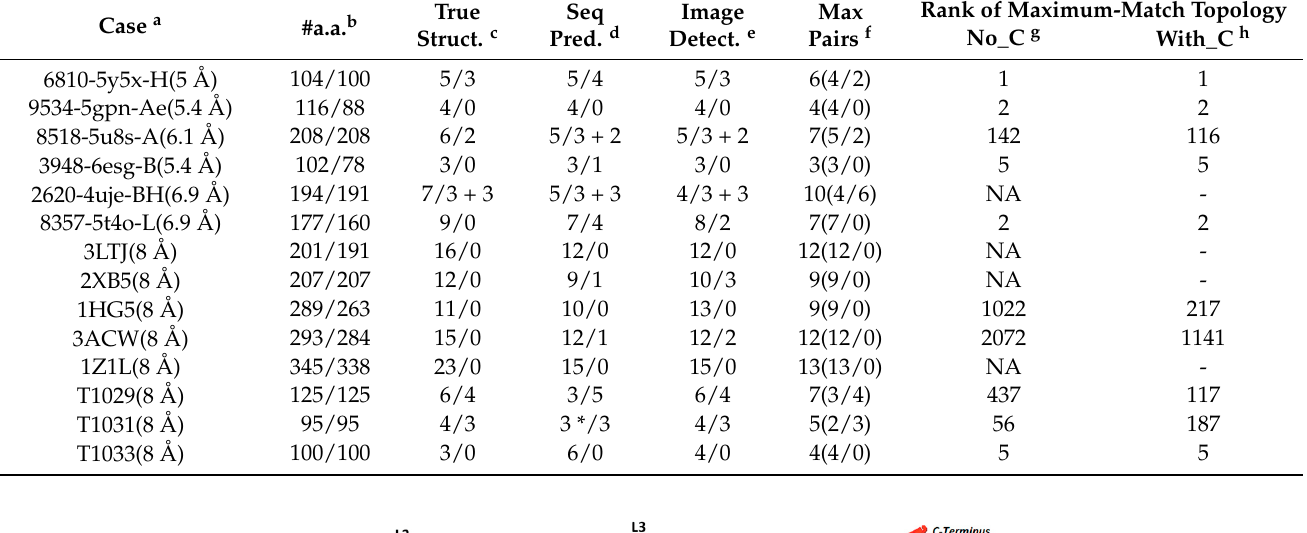
Table 2. The rank of the maximum-match topology produced using secondary structure sequence segments, traces, and amino acid contact pairs. a A test case involving a cryo-EM density map is labeled as EMDB ID-PDB ID-chain ID. A case involving a simulated density map is labeled using the PDB ID. A case involving a CASP target is labeled using the target ID. The resolution of a density map is indicated. b The number of amino acids in the protein (length of downloaded sequence/length in atomic structure). c The number of α -helices/ β -strands in the atomic structure. (+) indicates number of β -strands in each β -sheet. d The number of α -helices/ β -strands predicted using JPred. e The number of α -traces/ β -traces detected from the 3D density map. f The number of correctly matched secondary structures ( α -helices/ β -strands) that are included in the maximum-match topology. g Rank of the maximum-match topology without using contact pairs. h Rank of the maximum-match topology using contact pairs. *: Merge error in a predicted helix using JPred.